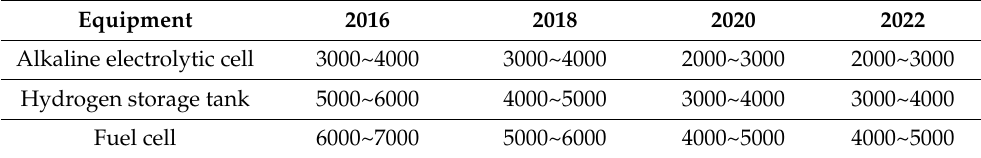
Table 3. Hydrogen energy equipment investment costs over the years.